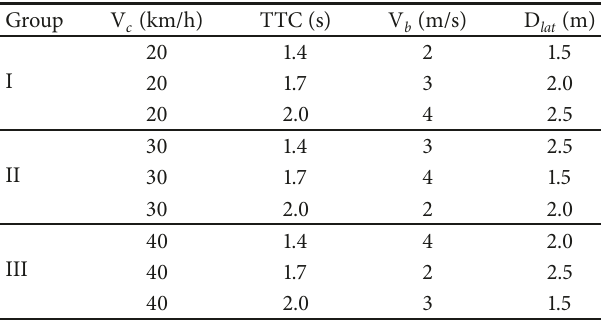
Table 2: Orthogonal experimental setup of SCR.